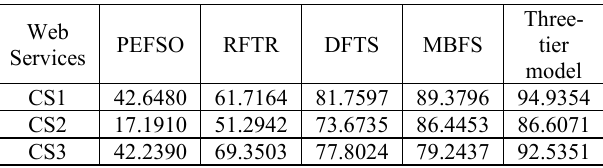
Table. 3. Comparison of Fairness resource